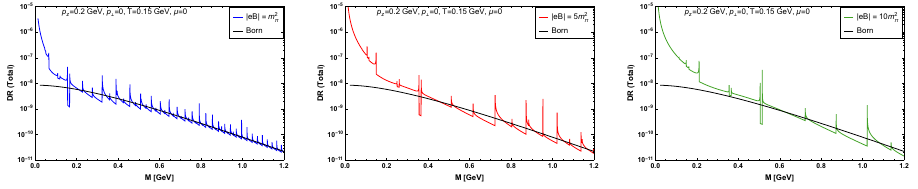
Figure 4. Rate plotted as a function of invariant mass for di ff erent values of eB . The figures are obtained for zero values of p ⊥